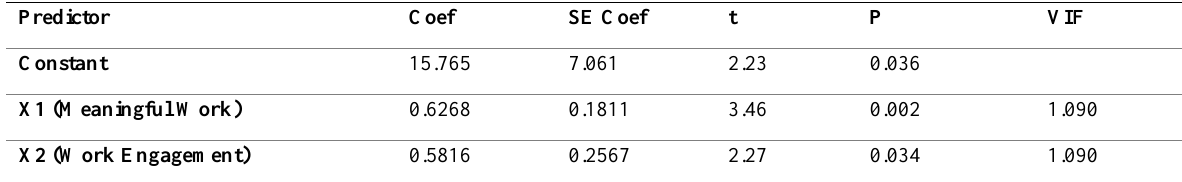
Table 1: Partial Parameter Significance